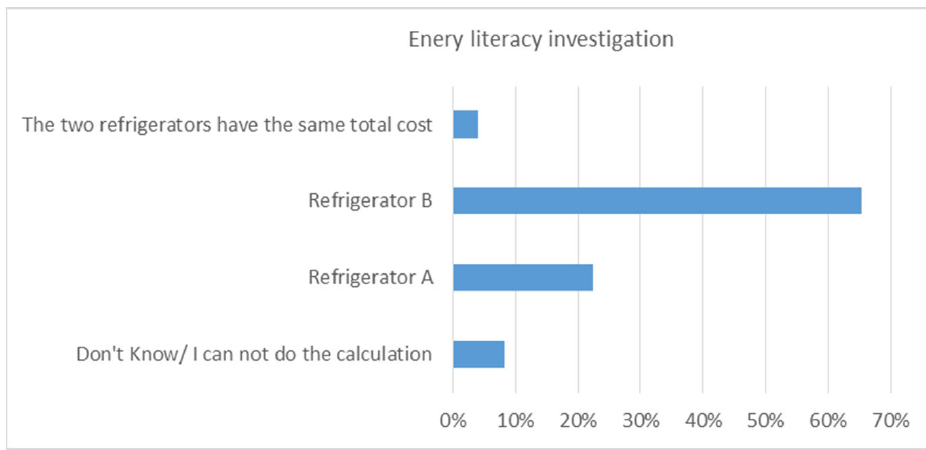
Figure 7. Investigating energy ‐ related financial literacy among respondents.